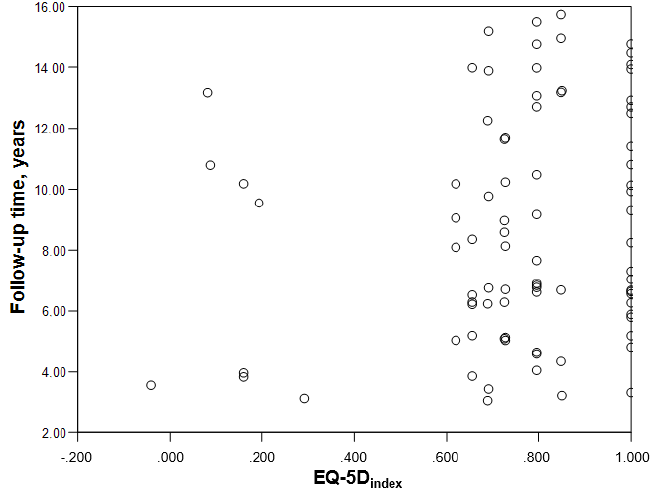
Figure 2. Scatterplot demonstrating lack of correlation between the time from surgery and the EQ-5D index.